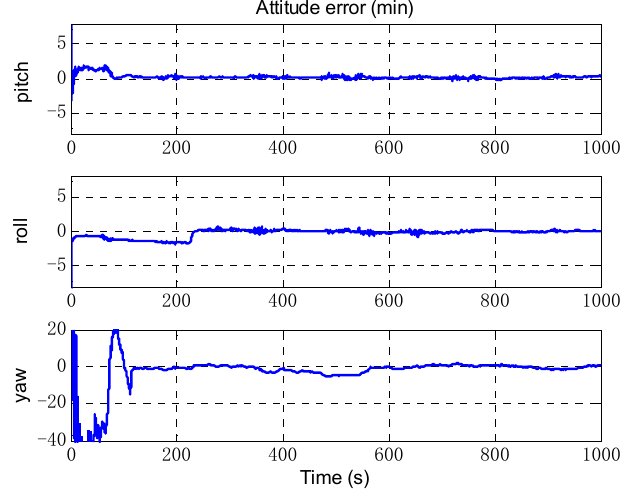
Figure 15. The estimation of attitude error.